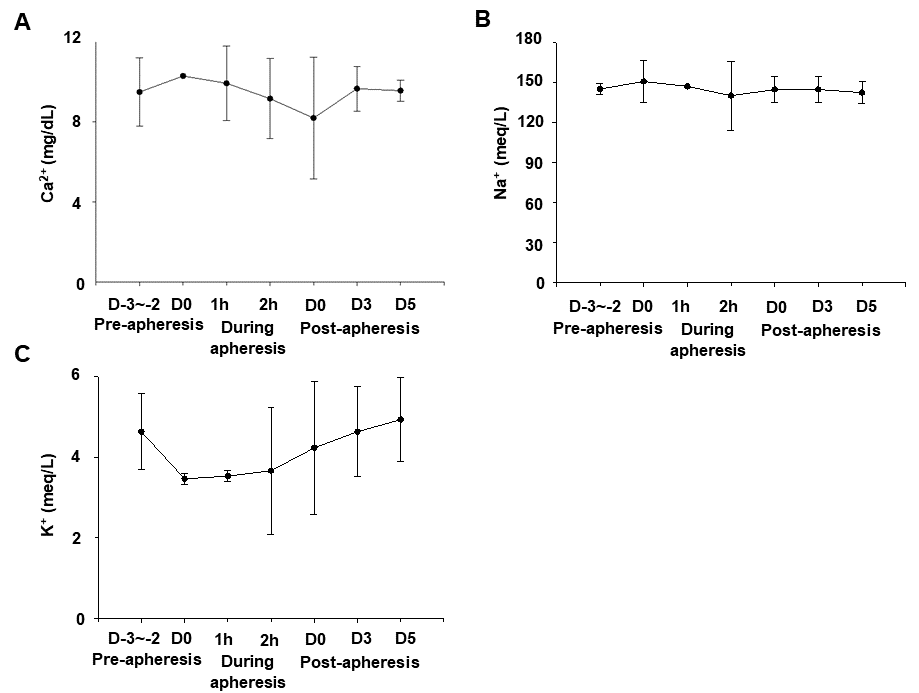
Figure 3. The transition of the blood concentrations of calcium (Ca 2+ ), sodium (Na + ), and potassium (K + ) in dogs. Blood samples were taken from the cephalic vein pre-apheresis (D-3~2), during apheresis (1, 2 h), and post-apheresis (D0, 3, 5). Values of Ca 2+ ( A ), Na + ( B ), and K + ( C ) were analyzed. Data were shown as mean ± S.E.M ( n = 3).